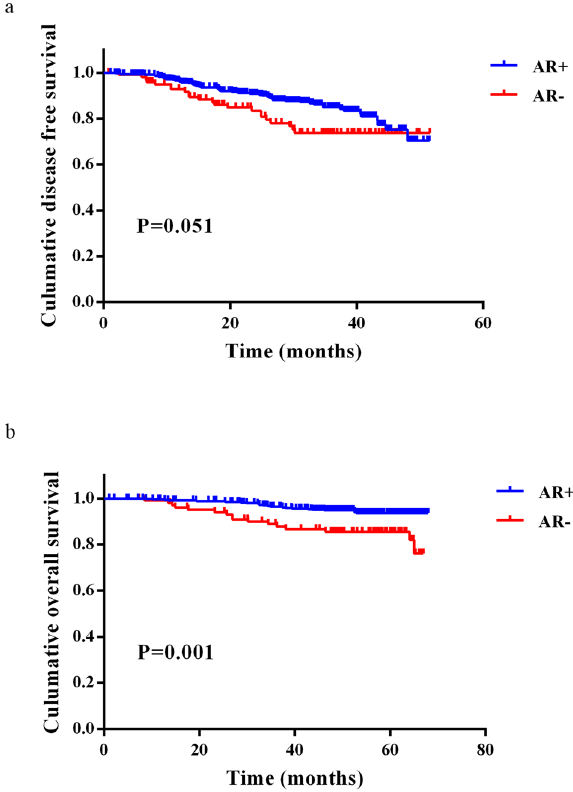
Fig. 1 Survival in patients with HER2 + nonmetastatic IDC according to AR expression. Kaplan – Meier curve for DFS ( a ) and OS ( b ) of breast cancer patients strati fi ed by AR